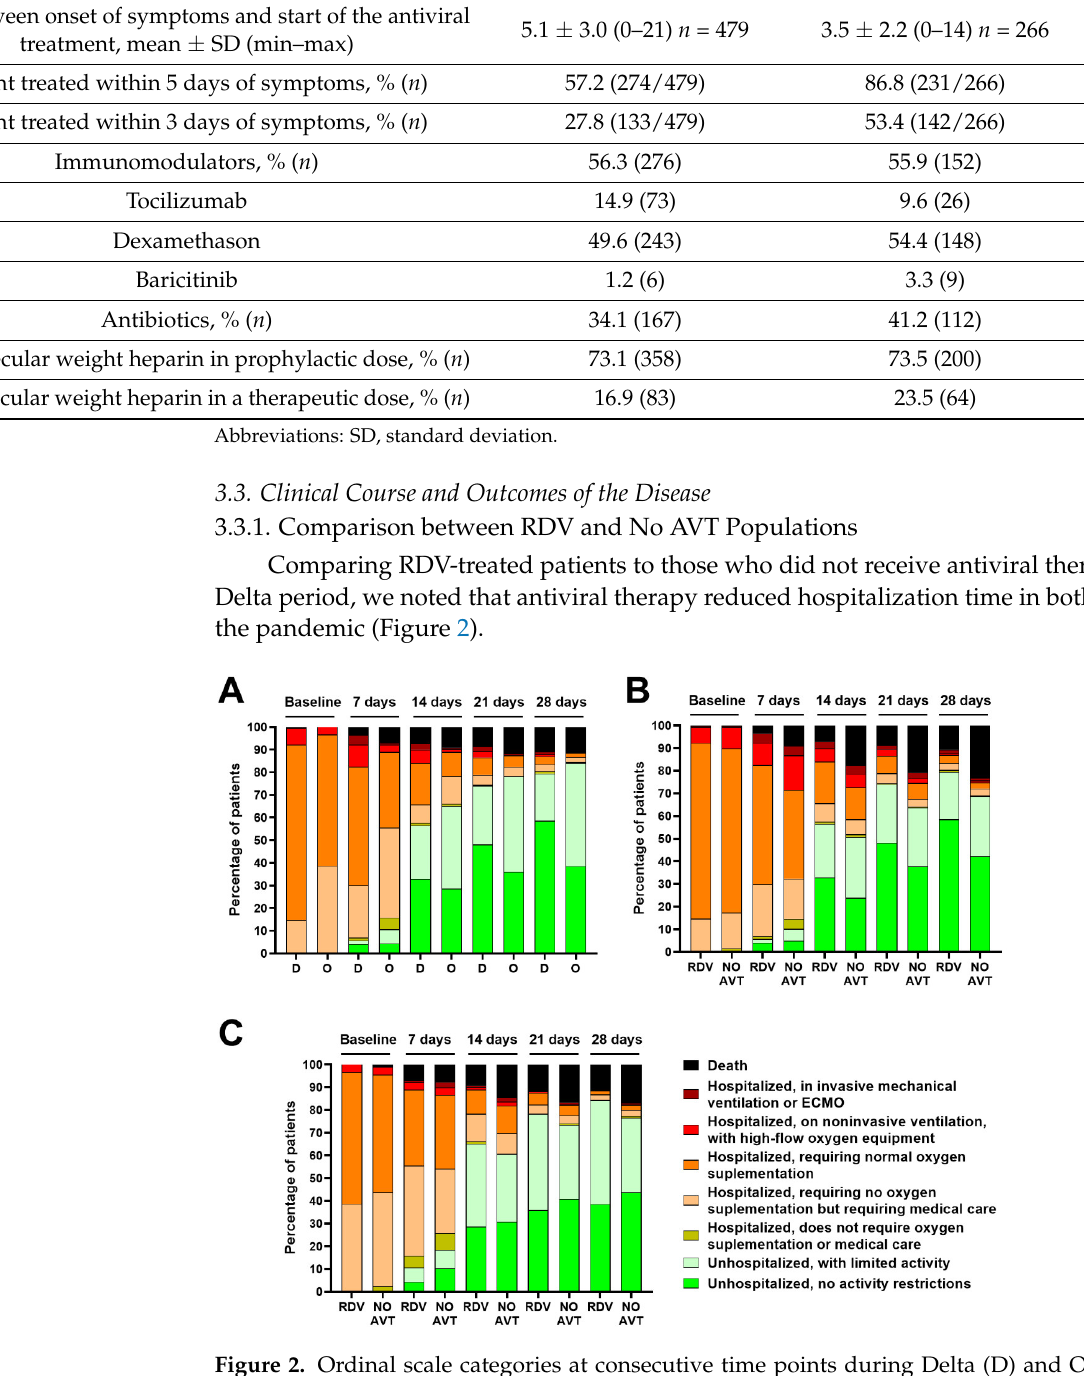
Figure 2. Ordinal scale categories at consecutive time points during Delta (D) and Omicron (O) surges in all patients treated with remdesivir ( A ), in all patients treated with remdesivir (RDV) or without antiviral treatment (NO AVT) during Delta ( B ) and Omicron ( C ) surges. Regardless of which variant of SARS-CoV-2 the patients were infected with, RDV therapy reduced the risk of death (Figure 2, Table 4).